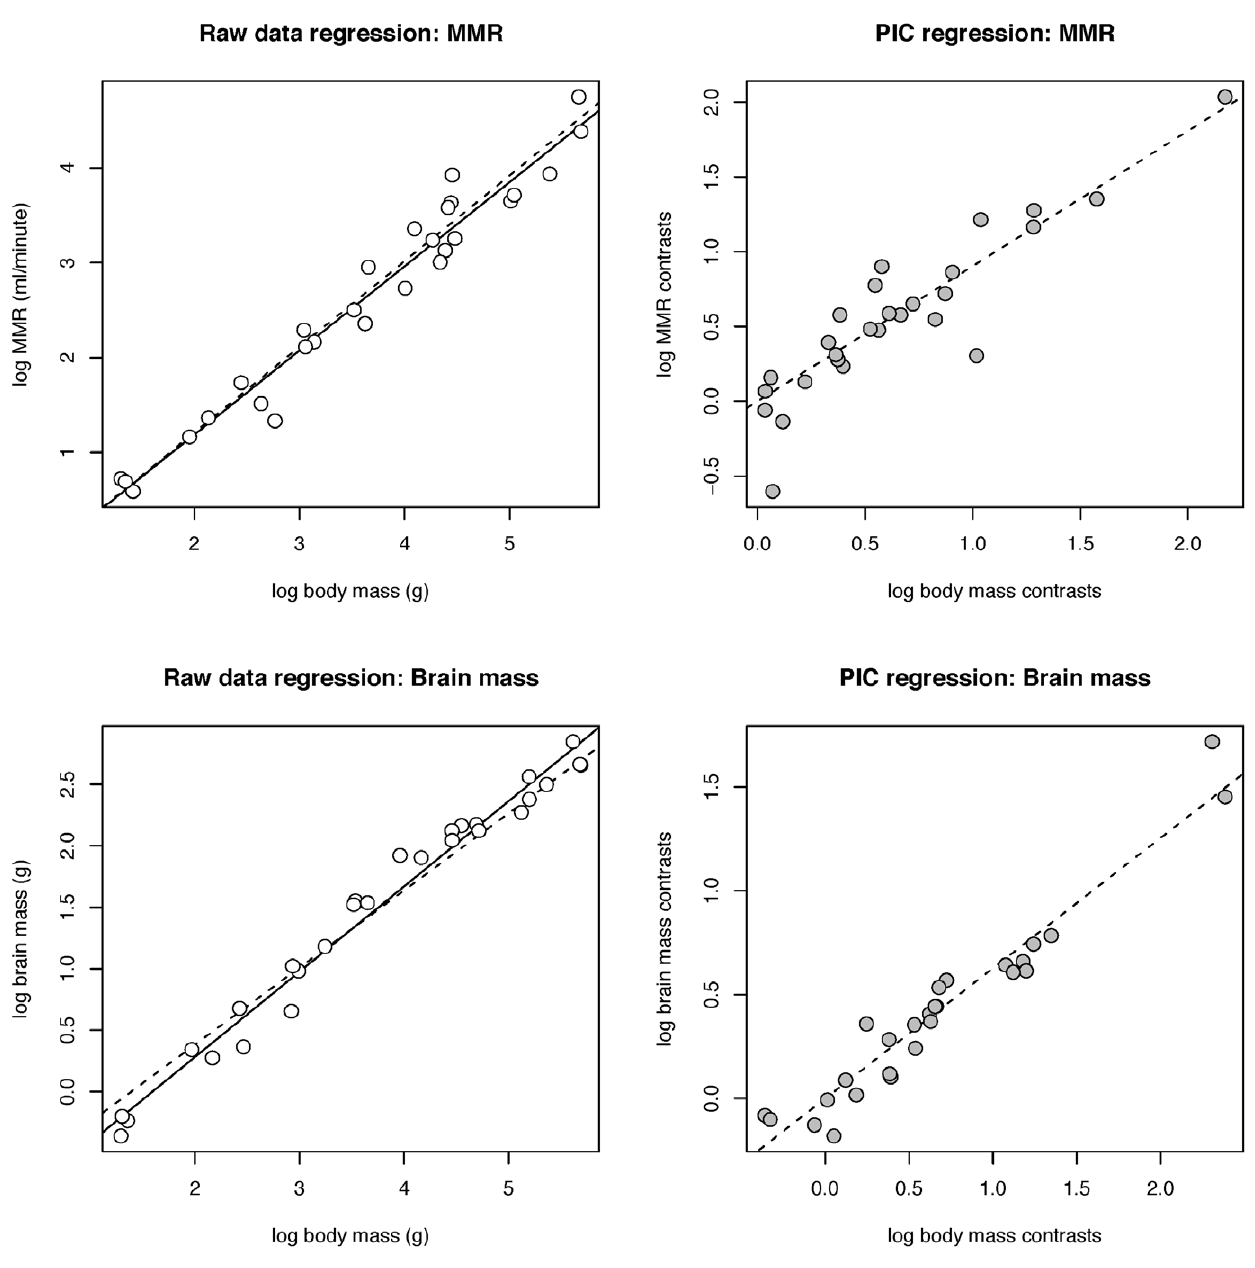
Figure 2. Relationships between body size, brain size and exercise capacity. A) and B) Relationship between body mass and MMR before and after controlling for phylogeny using PIC. C) and D) Relationship between body mass and brain size before and after controlling for phylogeny using PIC. Ordinary least squares regression lines shown as solid lines for raw data and as dotted lines for PIC. PIC regressions have been superimposed on raw data by passing them through the phylogenetically-weighted grand mean of the data sets following Garland and Ives